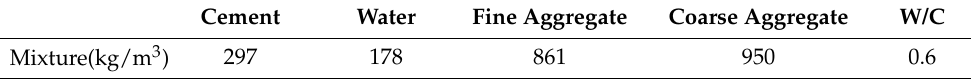
Table 1. Concrete mix proportion [24].